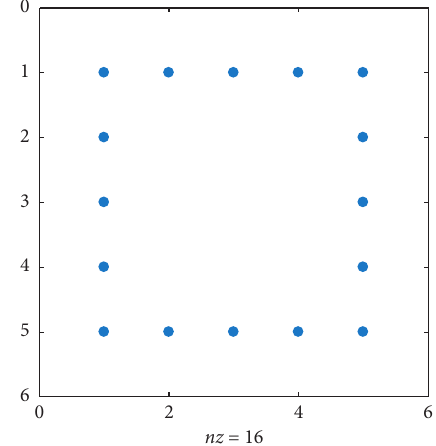
Figure 7: Transmit array configuration.